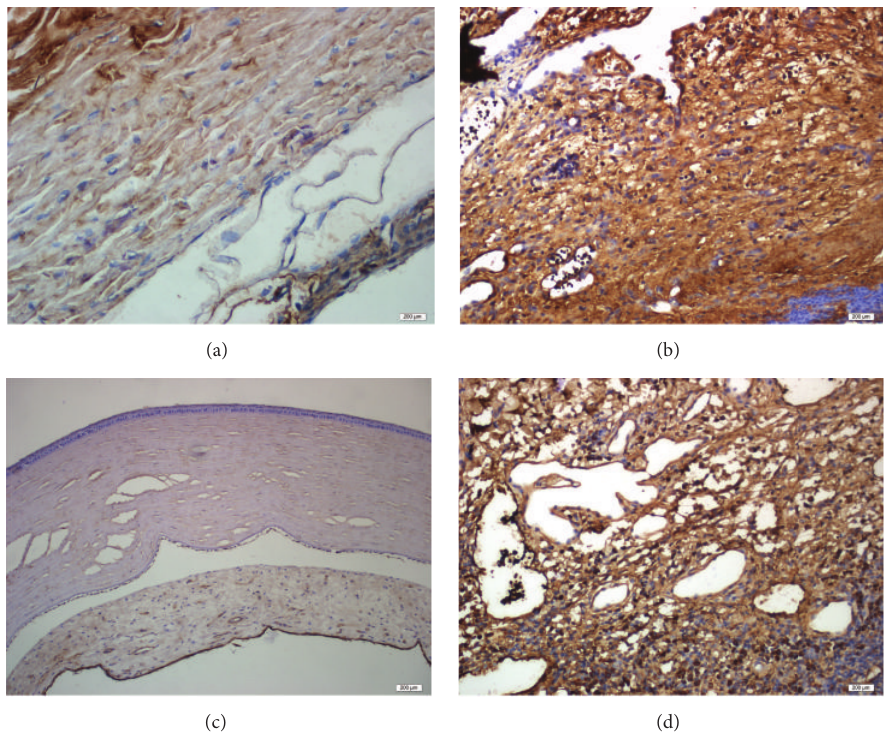
Figure 7: Immunohistochemical analysis of PDGF and TGF- 𝛽 . (a) Grade 0 staining of PDGF was observed on day 28 in the PRF membrane group. (b) Grade 1 staining of PDGF was observed on day 28 in the control group. (c) Grade 0 staining of TGF- 𝛽 was observed on day 28 in the PRF membrane group. (d) Grade 1 staining of TGF- 𝛽 was observed on day 28 in the control group.